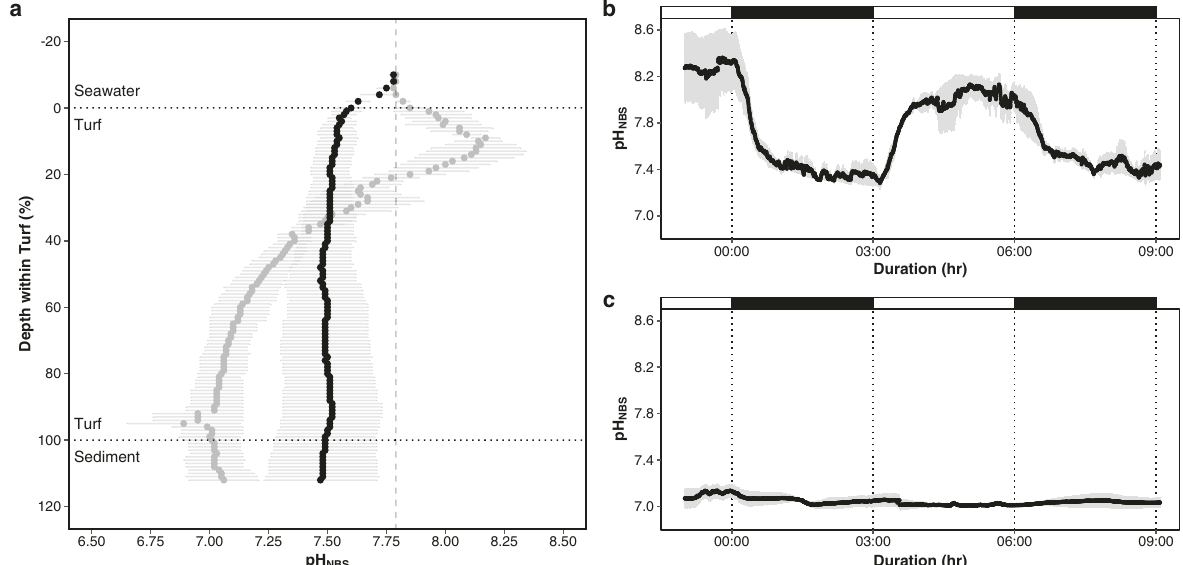
Fig. 5 Microchemical environment of turf algae and associated sediments, and its diurnal variability. a pH NBS pro fi le (mean ± S.E., n = 3 independent microcosms) within the turf algae and sediment in the laboratory incubations. Grey circles show measurements made in the light period, black circles show measurements made in the dark period. Note: 0% refers to the surface of the turf algae. b , c pH NBS measurements (mean± S.E., n = 3 independent microcosms) during 3-h light-dark cycles in the laboratory incubations (white shading above: light period, black shading above: dark period) at the point of maximal pH in the upper layer of the turf algae ( b ) and in the sediment below the turf algae ( c